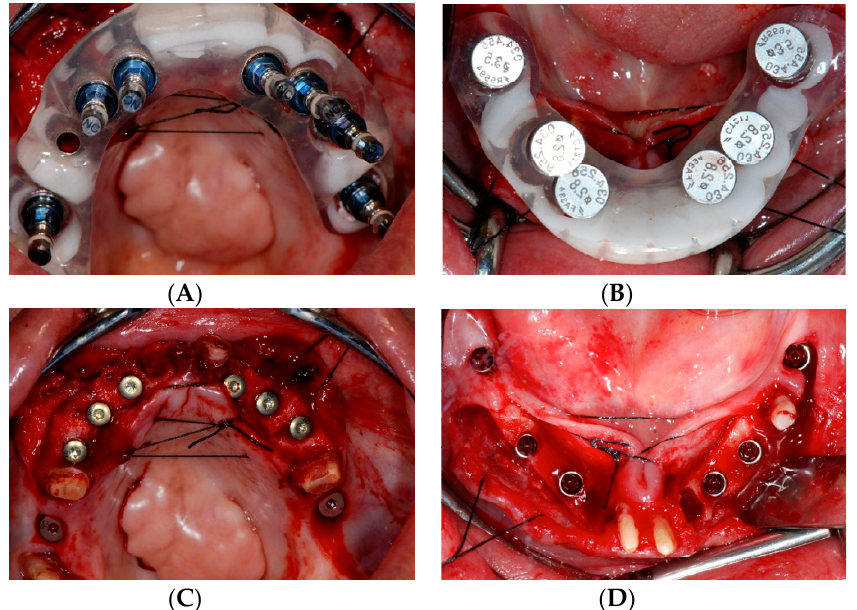
Figure 4. Computer-guided implant surgery. ( A ) Maxillary surgical template with guided mounts.